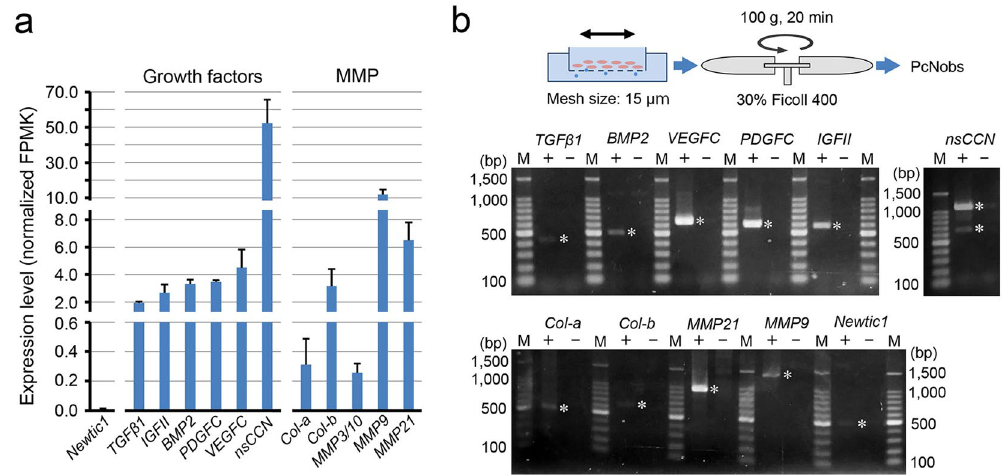
Figure 6. Circulating erythrocytes express genes of a large number of secretory molecules. ( a ) Relative gene expression levels of secretory molecules (growth factors and MMPs) as well as Newtic1 in whole blood. We carried out mRNA-seq (n = 3) and aligned the sequence reads on TOTAL (Supplementary Table S3). ( b ) PCR confirmation of gene expression in PcNobs (n = 3). PcNobs were purified (99.3–99.8%) from whole